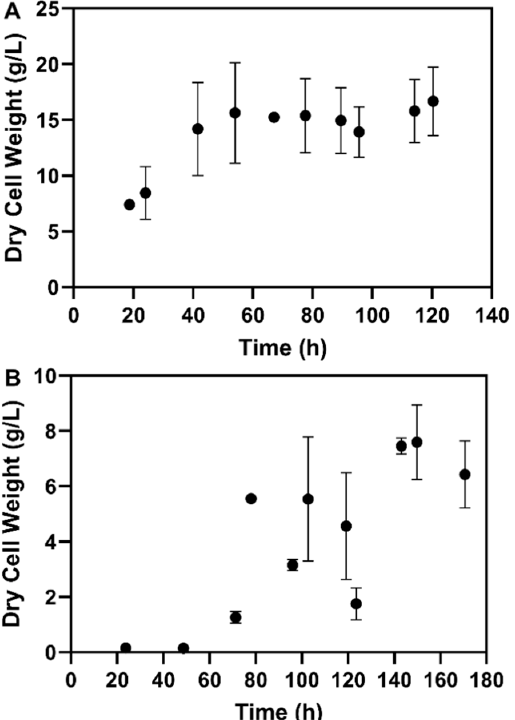
Figure 3. Growth curve profiles for ( A ) M. circinelloides , and ( B ) M. alpina , grown on animal fat by-product materials.